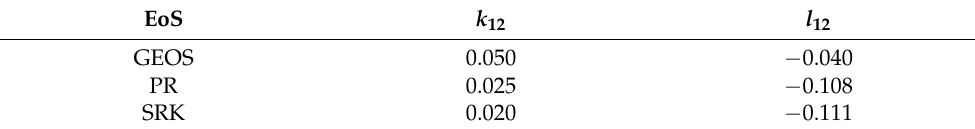
Table 6. Binary interaction parameters used in calculations [37].